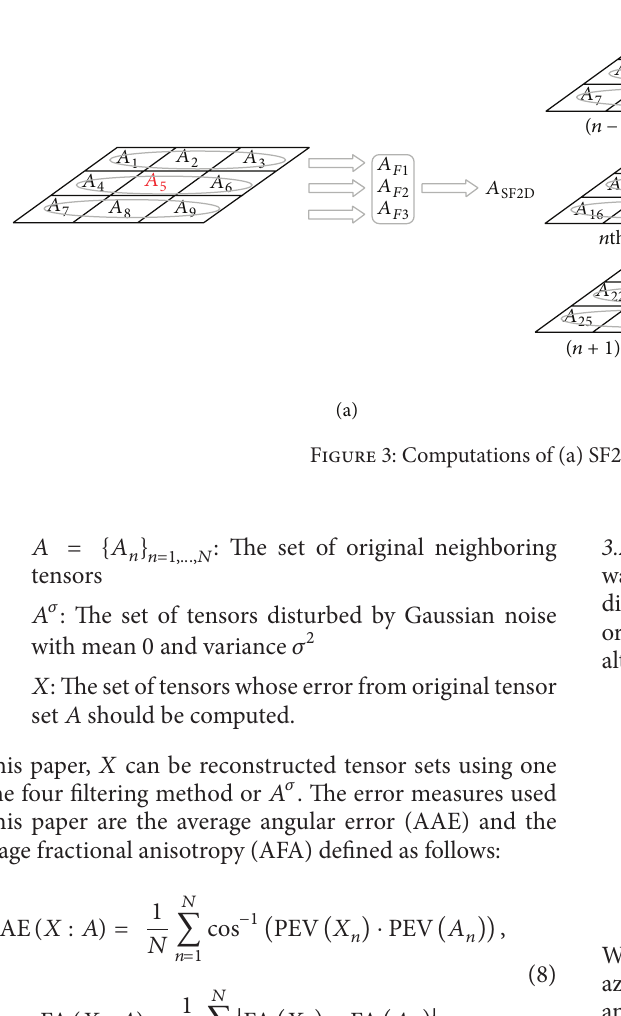
Figure 2: Computing Fermat point 𝐹 (a) when one of the three angles is greater than 120 ∘ and (b) when all the three angles are less than 120 ∘ . In the latter case, the Fermat point is the intersection of the two straight lines 𝐴 1 𝐴 󸀠 1 and 𝐴 3 𝐴 󸀠 3 .